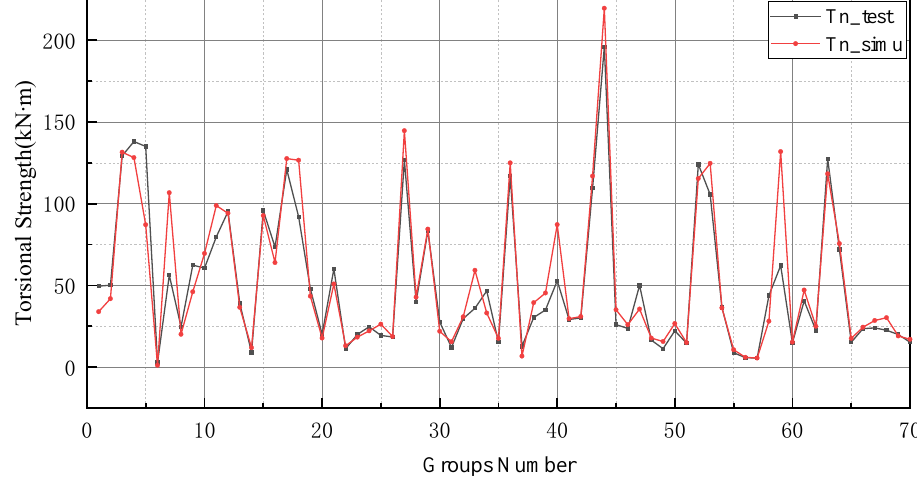
Figure 8. Error distribution between different models. ( a ) Error comparison between BPNN and GA-BPNN. ( b ) Error comparison between BPNN and optimized BPNN. ( c ) Error comparison be- tween optimized BPNN and GA-BPNN. ( d ) Error comparison between GA-BPNN and optimized GA-BPNN. ( e ) Error comparison between optimized BPNN and optimized GA-BPNN.